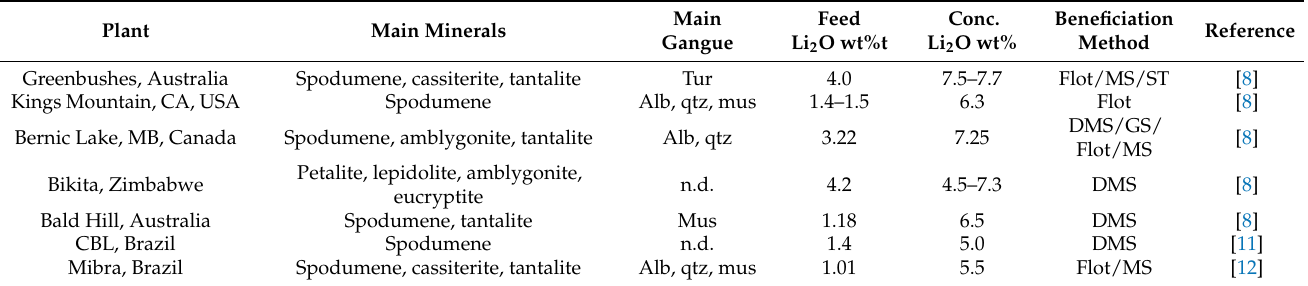
Table 1. Main ore and gangue minerals and typical metallurgical results for some processing plants